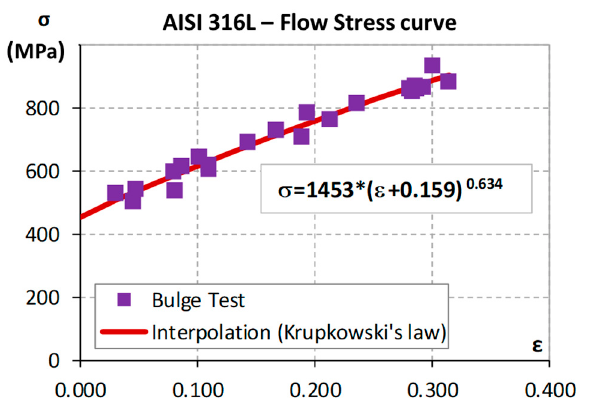
Figure 3. AISI 316L flow stress curve. Table 1. FEM model details.